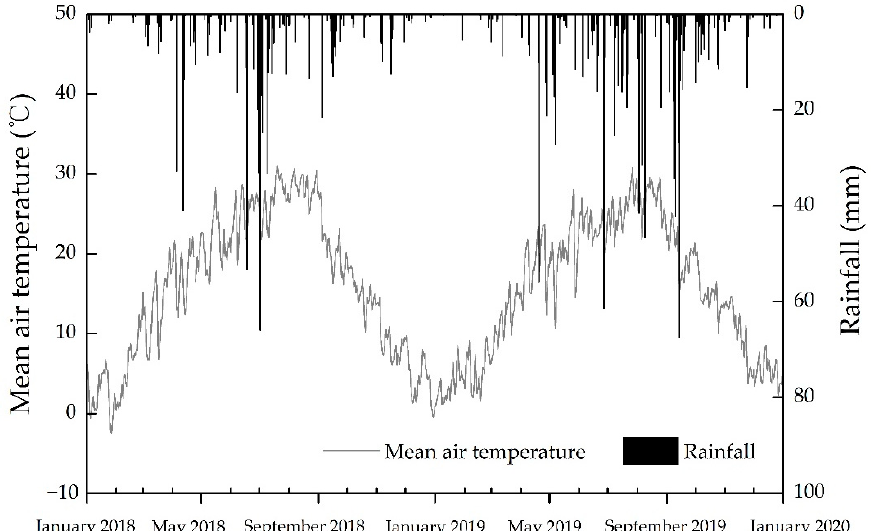
Figure 1. Daily mean temperature and rainfall from 2018 to